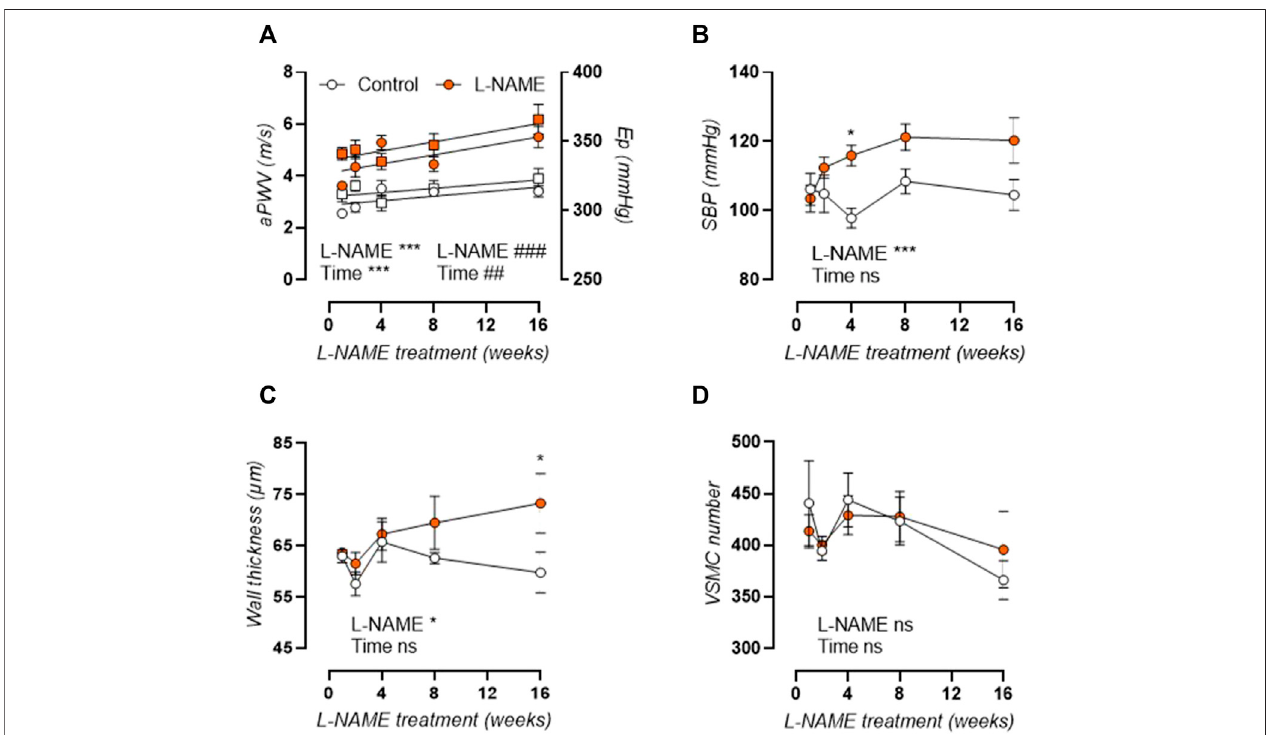
FIGURE2| AorticstiffnessdevelopspriortoperipheralhypertensioninL-NAMEtreatedC57Bl/6mice.AorticPWV(aPWV,circles,left Y -axis)and exvivo Peterson modulus (E p , squares, right Y -axis) at isobaric80 – 120 mmHg distendingpressure (A) and systolic blood pressure (SBP, (B) ) are shown for longitudinal L-NAME treated (n ≥ 7) and control (n ≥ 9) mice. Histology (n = 5) was employed to assess medial wall thickness (C) and VSMC number (D) . Linear regression is shown on for the aortic stiffness (aPWV and E p )-treatment duration relationship in A. Statistical analysis using two-way ANOVA. Overall signi fi cance (bottom) and post-hoc signi fi cance (in graph) are listed. Post-hoc signi fi cance was not listed in A. * p < 0.05, ** p < 0.01, *** p < 0.001. ## p < 0.01, ### p < 0.001 for parameter E p in